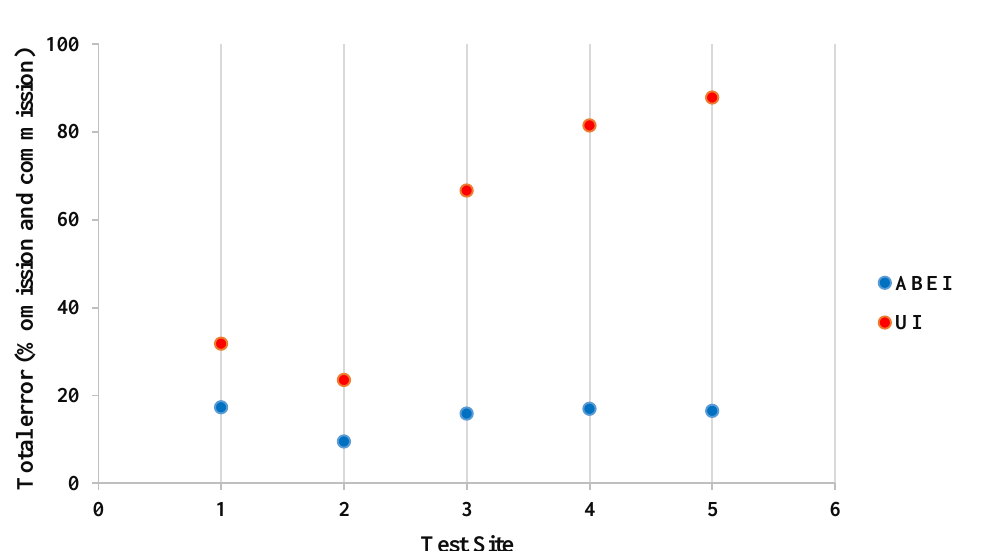
Figure 3. Total classification error (combined commission and omission errors).